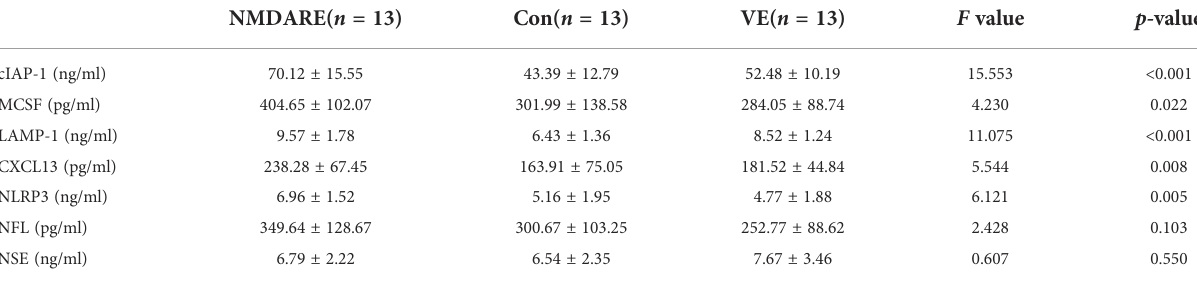
TABLE 3 Comparison of CSF seven cytokines and in fl ammatory mediator levels among anti-NMDAR encephalitis, controls, and viral